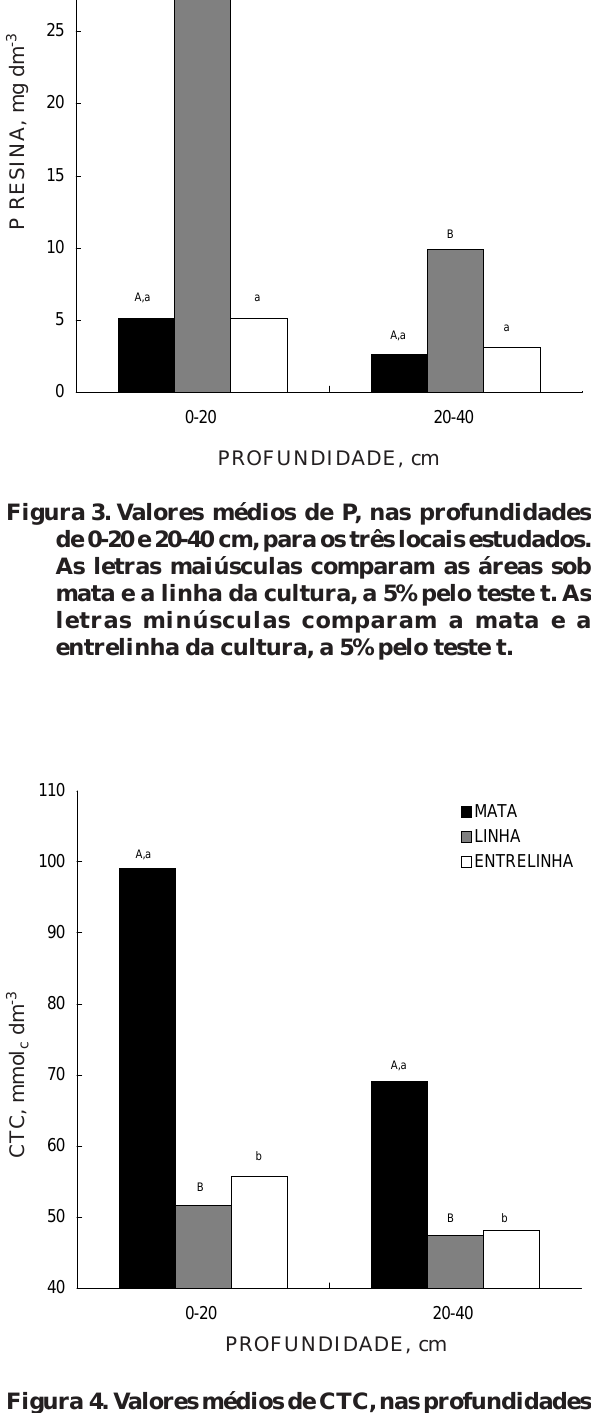
Figura 4. Valores médios de CTC, nas profundidades de 0-20 e 20-40 cm, para os três locais estudados. As letras maiúsculas comparam as áreas sob mata e linha da cultura, a 5% pelo teste t. As letras minúsculas comparam a mata e a entrelinha da cultura, a 5% pelo teste t.